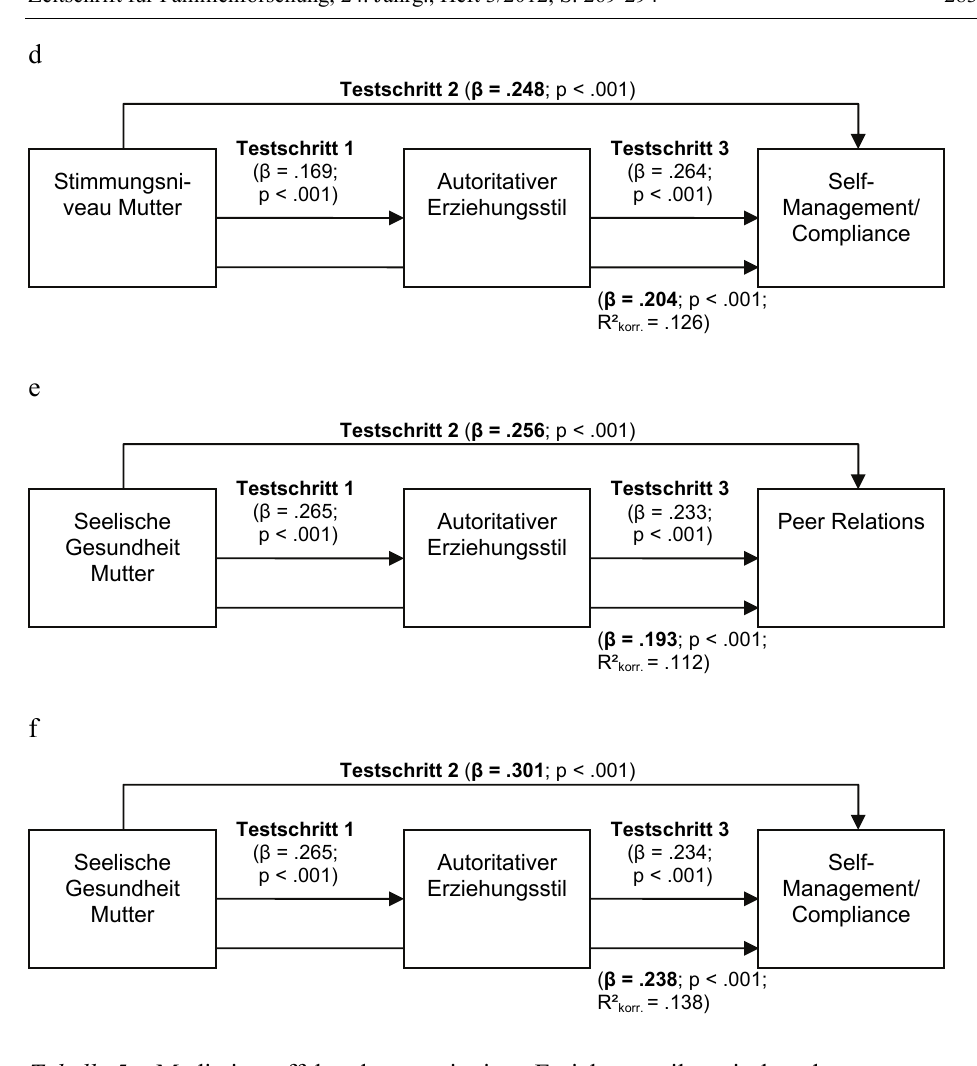
Tabelle 5 : Mediationseffekte des autoritativen Erziehungsstils zwischen dem Wohlbefinden der Mutter und den sozial-emotionalen Kompetenzen des